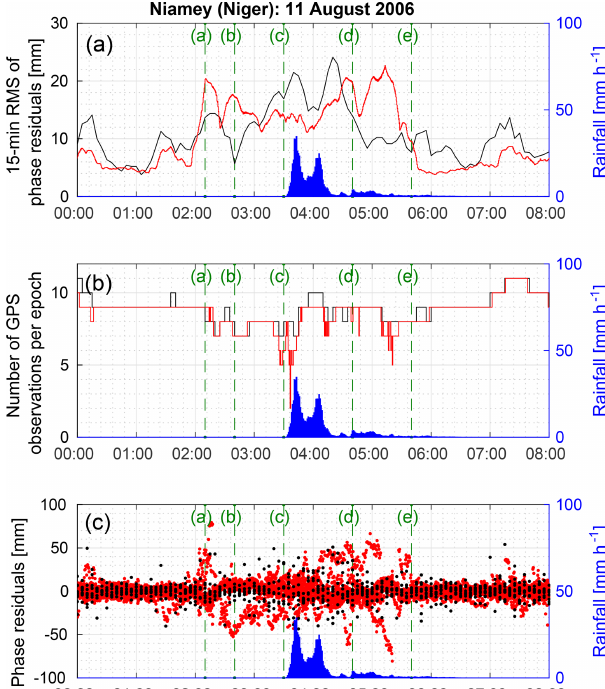
Figure 9. Outputs from GIPSY-OASIS (black) and GAMIT (red) software during the MCS event on 11 August 2016 at Niamey (Niger): (a) the 15min RMS of GPS phase residuals (mm), (b) the number of GPS observations per epoch and (c) GPS phase residuals (mm) at full temporal resolution (5min for GIPSY-OASIS and 30s for GAMIT). Rainfall (mmh − 1 ; blue bar plots) is retrieved from the ARM Mobile Facility. The times of the reflectivity maps given in Fig. 6 are shown using vertical dashed green lines and correspond to (a) 02:10UTC, (b) 02:40UTC, (c) 03:30UTC, (d) 04:40UTC, and (e)